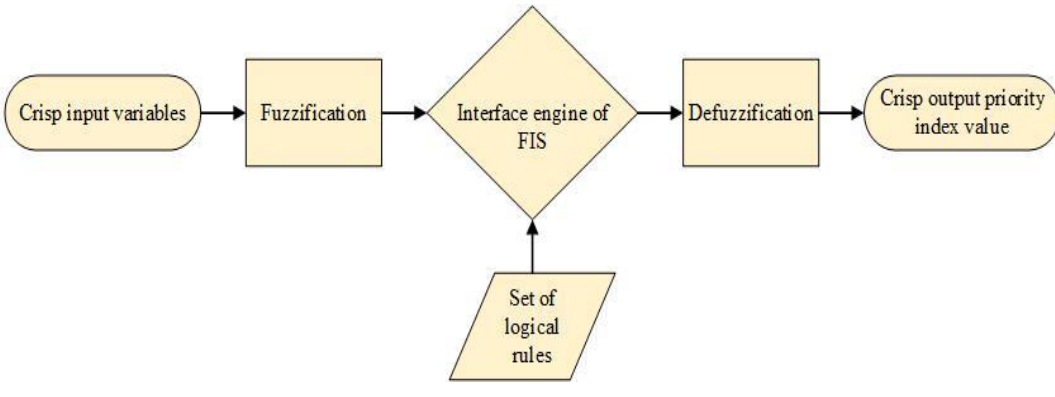
Figure 3. Fuzzy inference system.